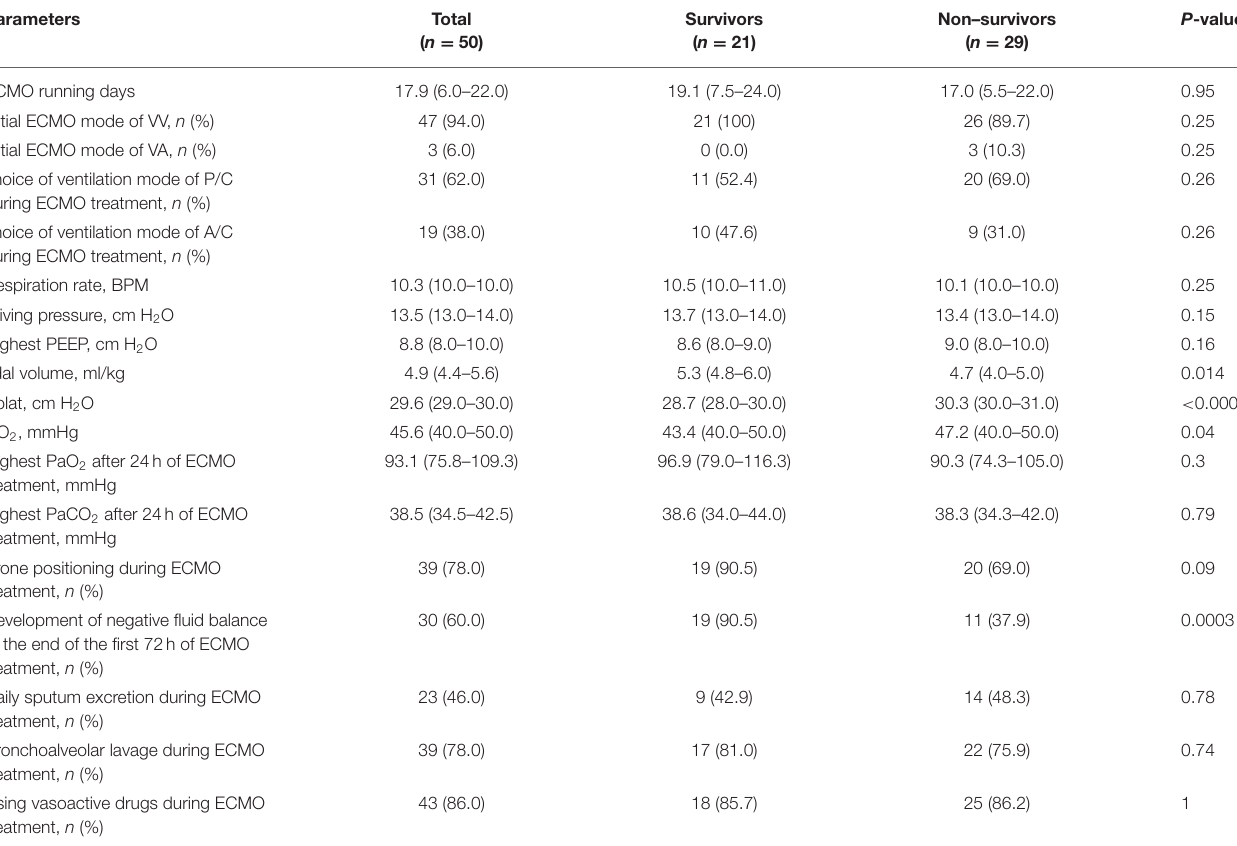
TABLE 3 | Lung function and treatment details after commencement of